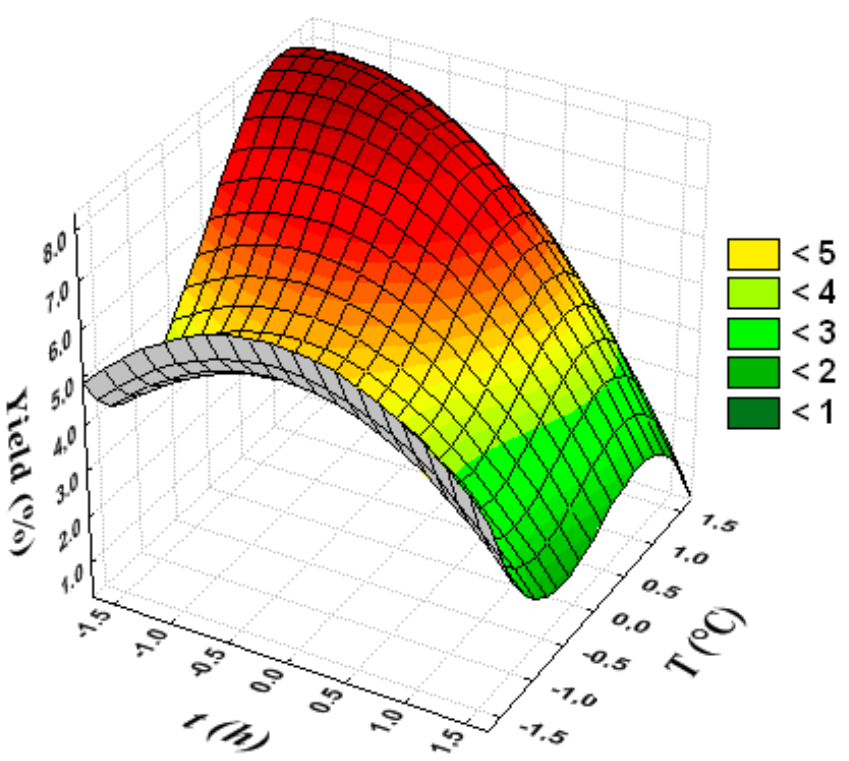
Figure 3. Response surface to show the mutual influence of processing time and temperature on extraction yield. extraction yield.